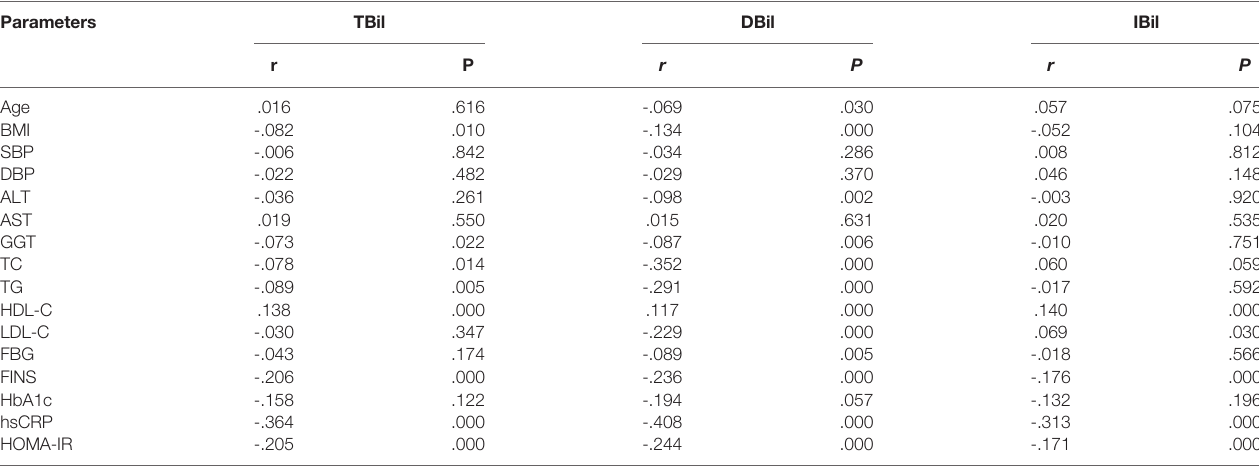
TABLE 2 | Correlation between bilirubin and clinical parameters in all participants. Parameters